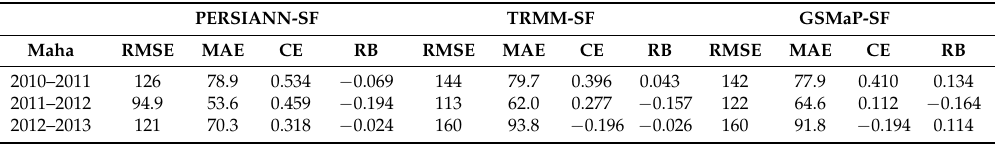
Unit: m 3 /second for RMSE and MAE, no dimension for CE and RB. Table 6. Evaluated error of the calculated discharge in the Maha seasons, in comparison of the calculated discharge with Gauged-R